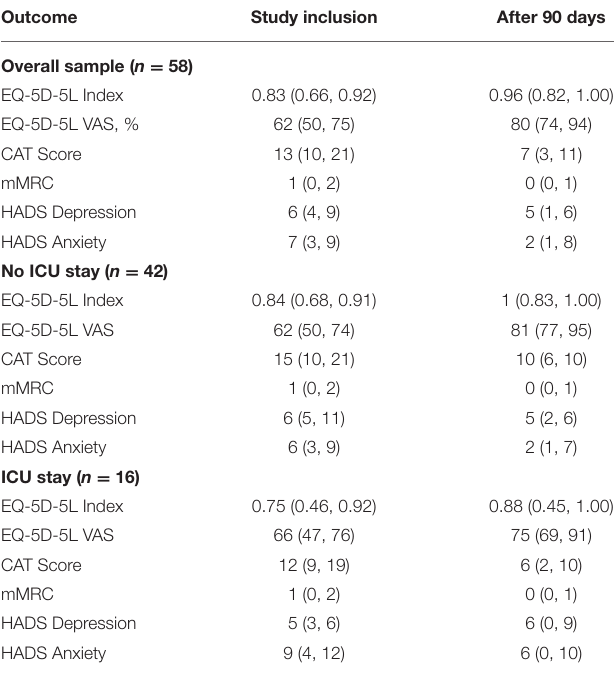
TABLE 3 | Changes in all study outcomes from inclusion to study